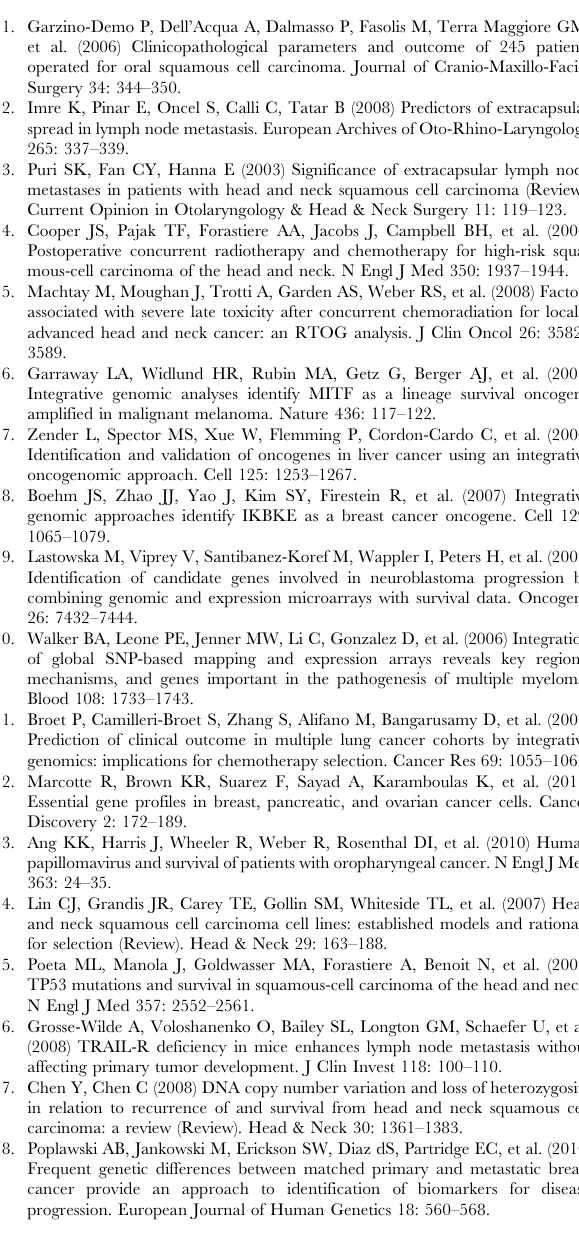
Table S6 MISSION siRNA Human Gene Family Set used for kinase knockdown.